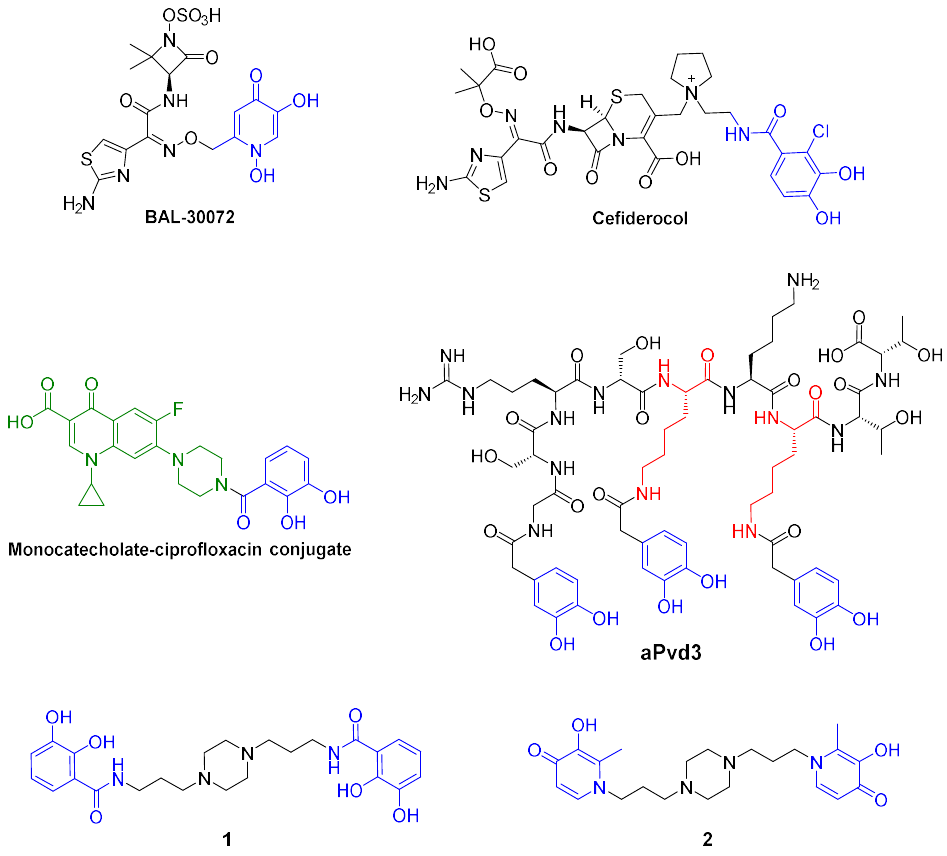
Figure 1. BAL-30072, cefiderocol, monocatecholate–ciprofloxacin conjugate, aPvd3 and synthesized siderophore mimetics 1 and 2 .